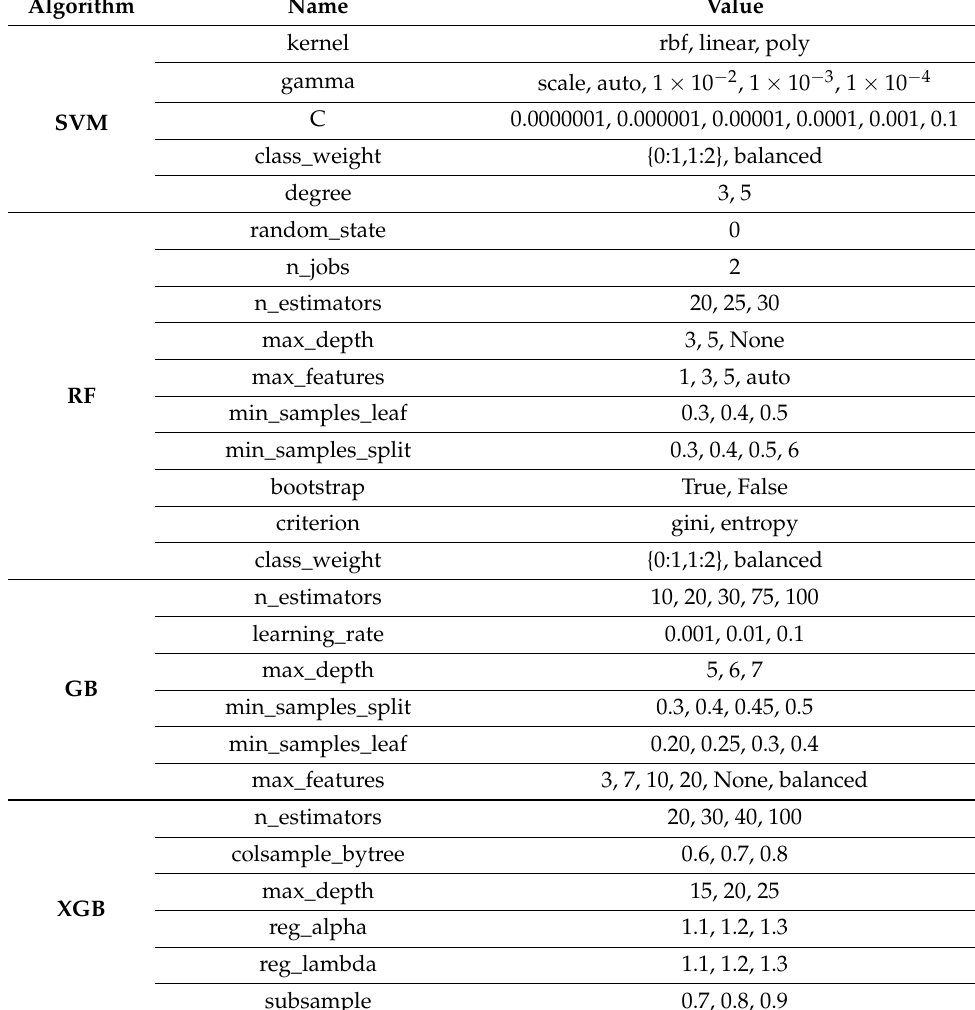
Table 3. Hiperparameters used for algorithms based on ensembles and SVM.